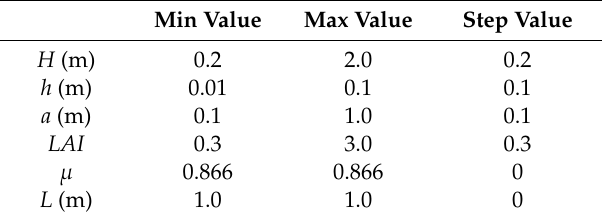
Table 4. Row structure configuration for row e ff ect index (REI) spanning growth season.